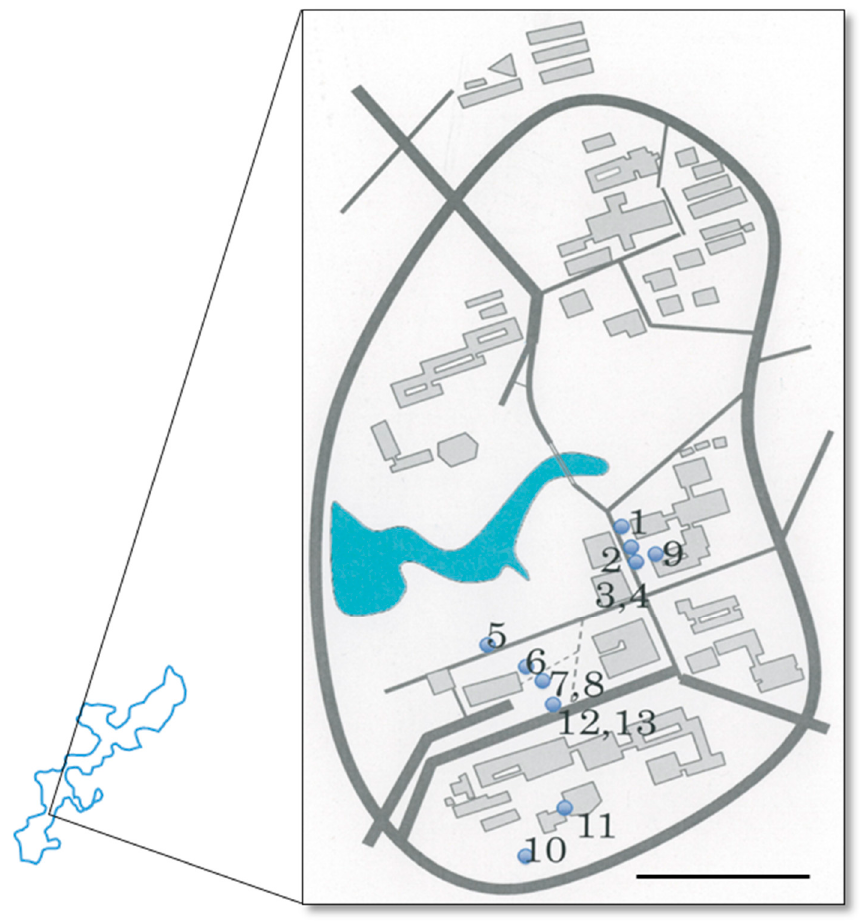
Figure 1. Sampling points at the Nishihara campus of the University of the Ryukyus (circles). 1: Ru1, 2: Ru3, 3: Ru4, 4: Ru5, 5: Ryu1, 6: Ryu2, 7: Ryu3, 8: Ryu4, 9: Ryu5, 10: Ryu7, 11: Ryu8, 12: Ryu9.1, 13: Ryu9.2. Scale bar = 200 m.